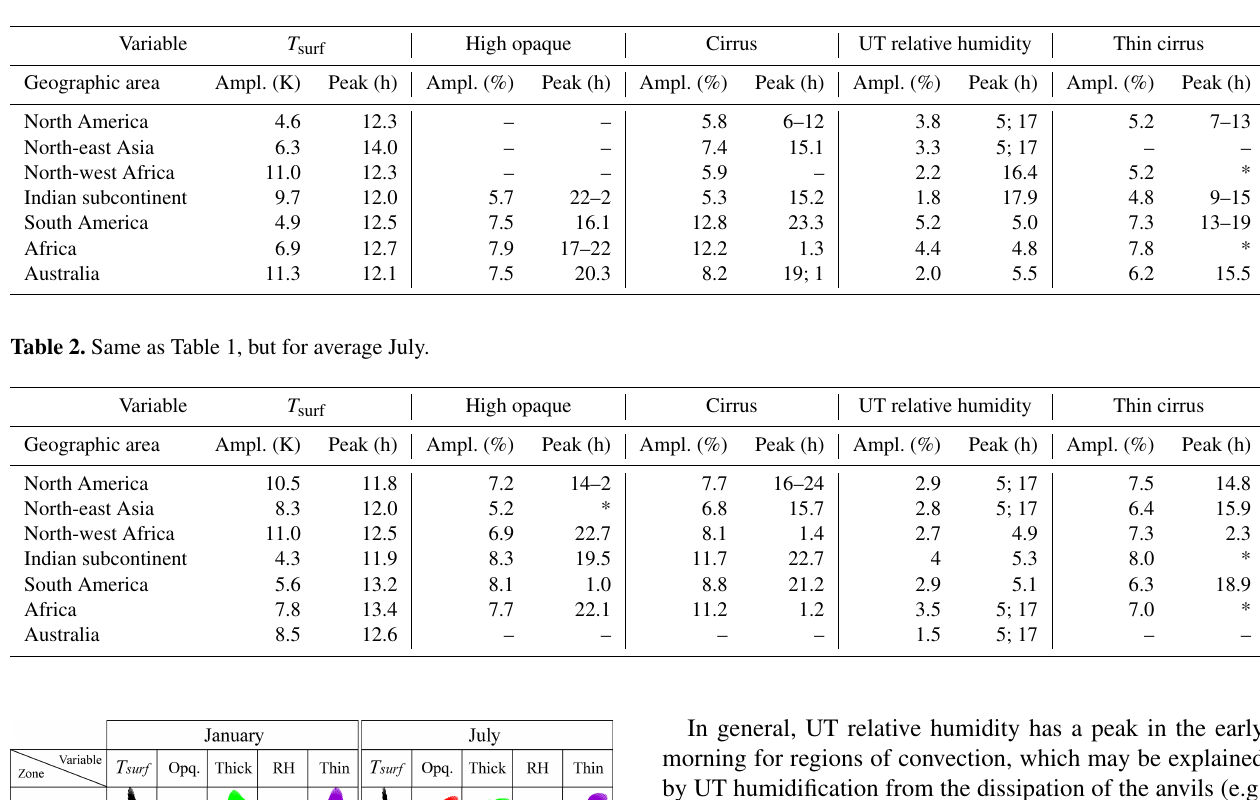
Table 1. Diurnal cycle amplitude and local time of the peak for T surf , high opaque clouds, thick cirrus, thin cirrus, and relative humidity for average January. Long dash symbol (–) means that no reliable cycle was detected while a star symbol (*) corresponds to multiple peaks in the circular histogram (see Fig. 9).